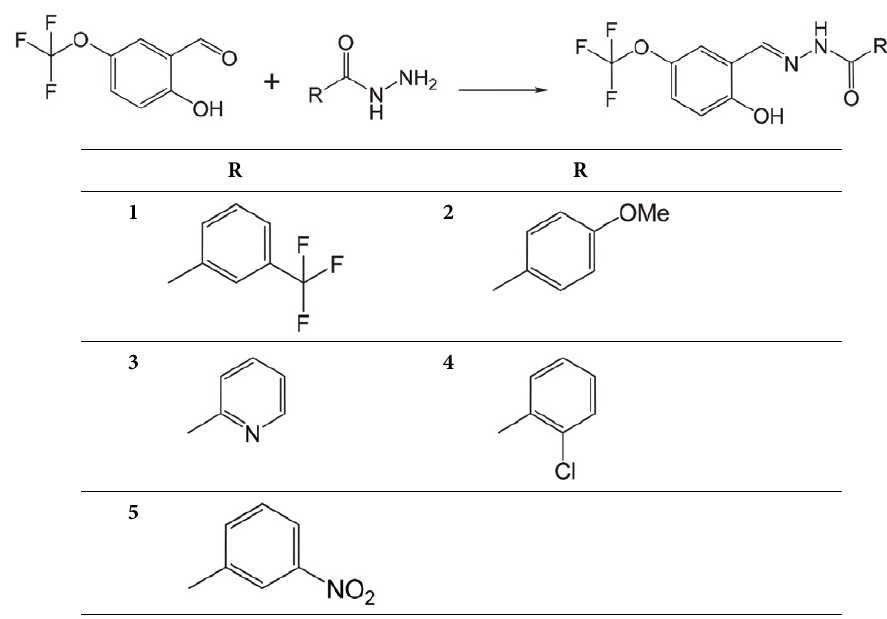
Scheme 1. Synthesis of the compounds 1 – 5